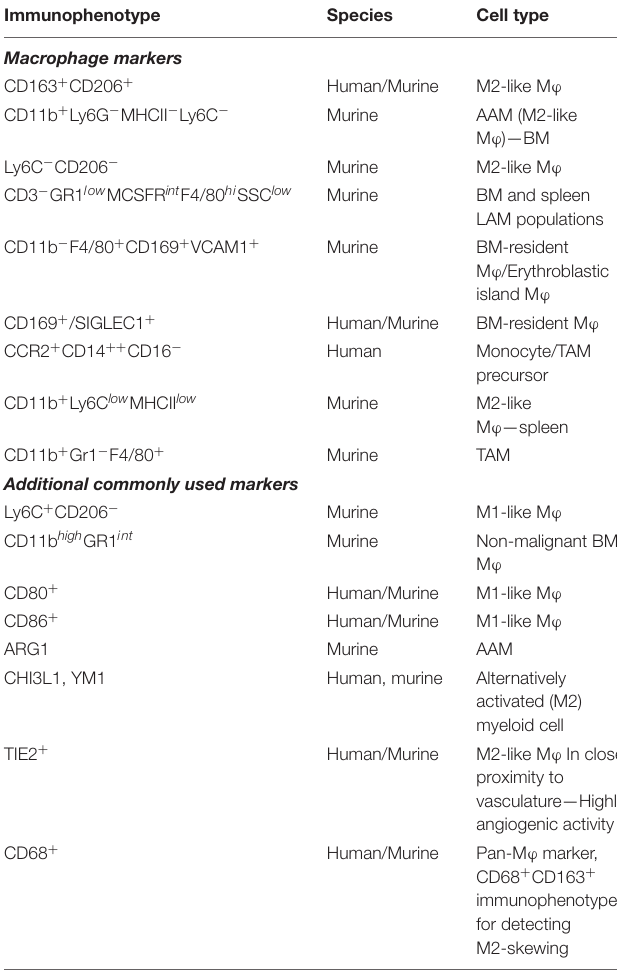
TABLE 1 | List of macrophage immunophenotype markers utilised for in vivo and in vitro